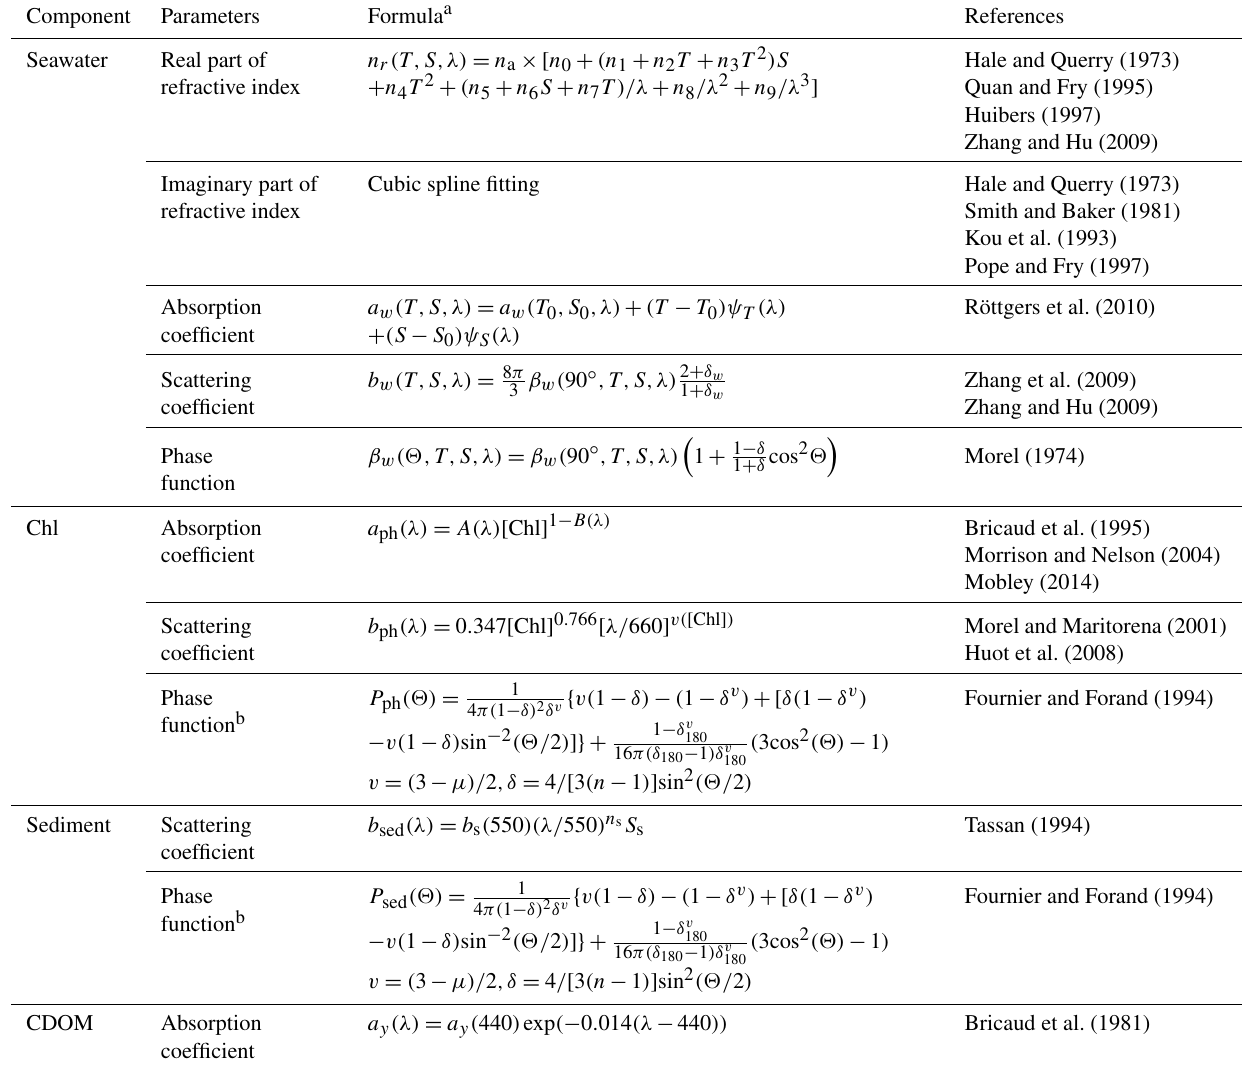
Table 2. Bio-optical ocean module used in the RT